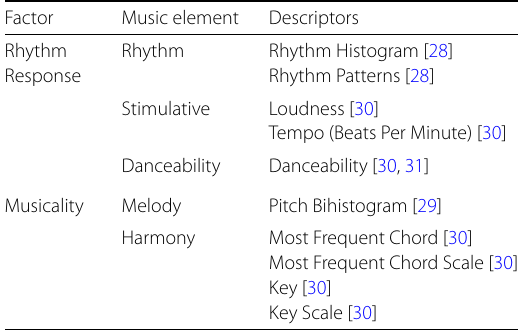
Table 1 Descriptors for each music elements that are being extracted as music feature, and its